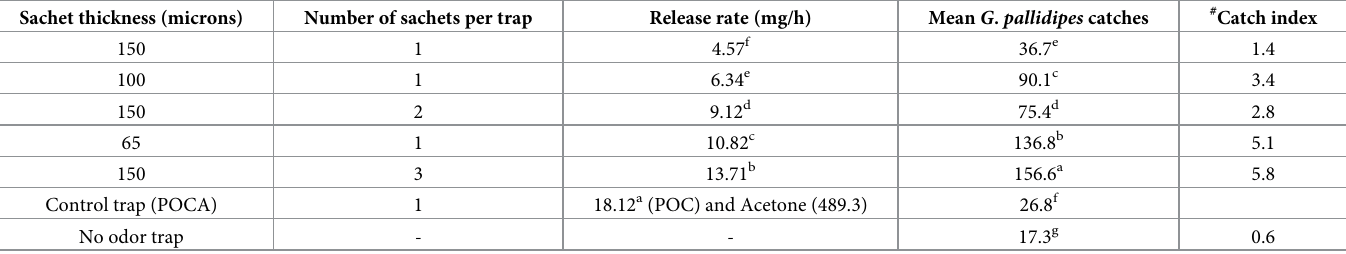
Means followed by different letters are significantly ( p < 0.05; ANOVA and LSD post-hoc analyses) different # Total mean catch expressed as proportion of that of the control